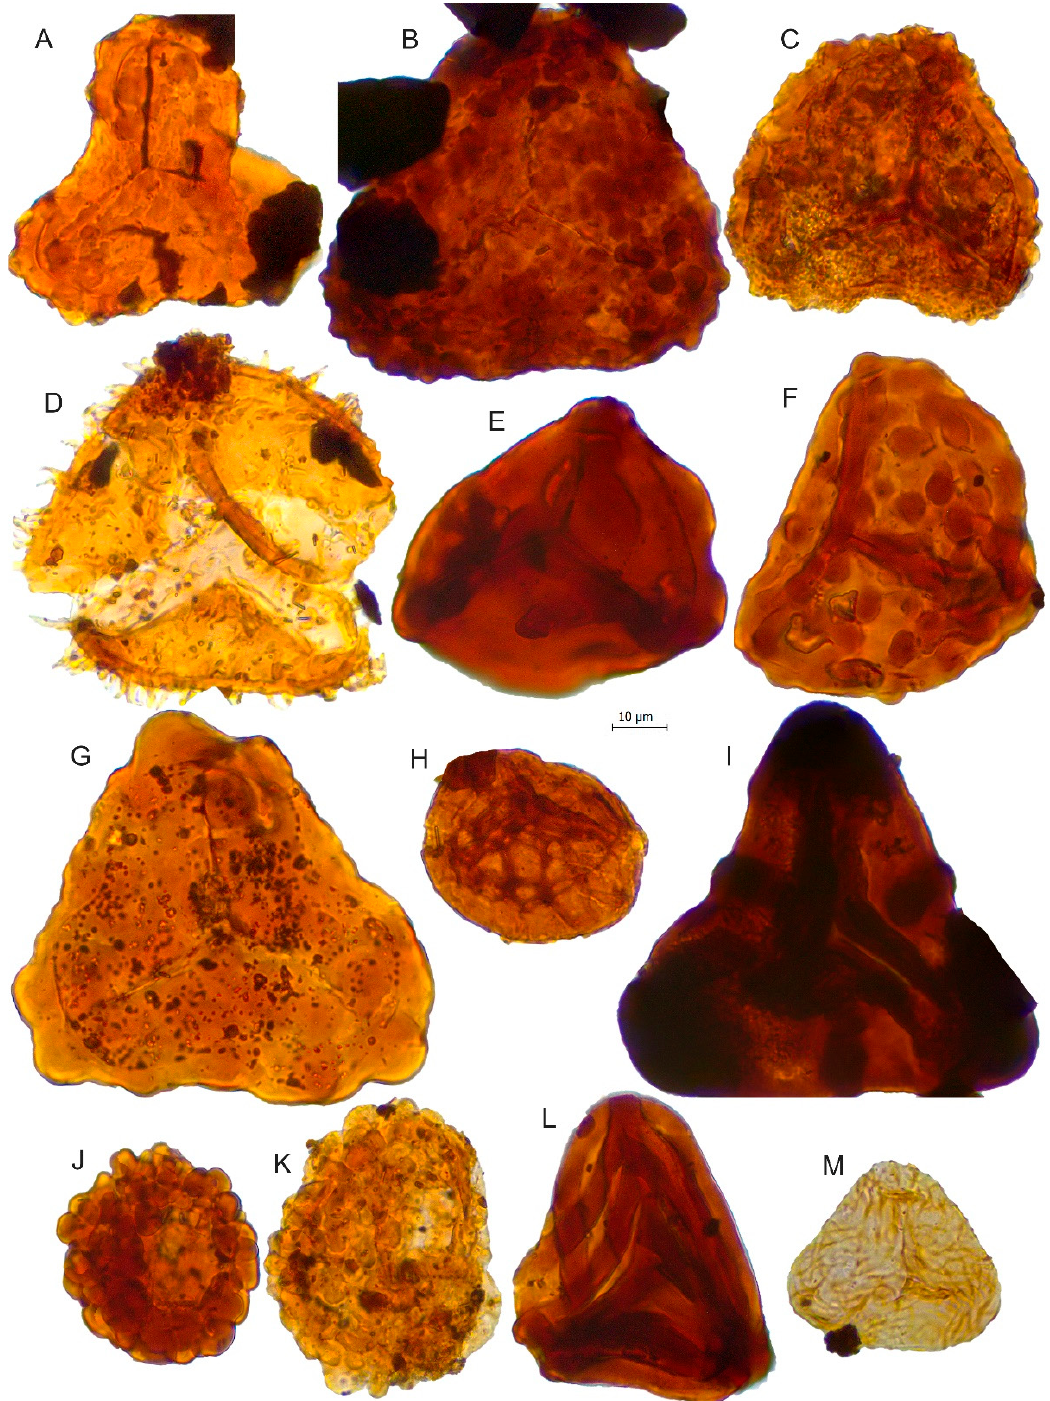
Figure 7 . Scale bar: 10 µm. ( A ) Impardecispora apiverrucata , JVLP-A-1-C114; ( B ) Impardecispora sp., JCLP-B-4-R260; ( C ) Concavissimisporites variverrucatus , JVLP-3-1-f464; ( D ) Pilosisporites trichopapillosus